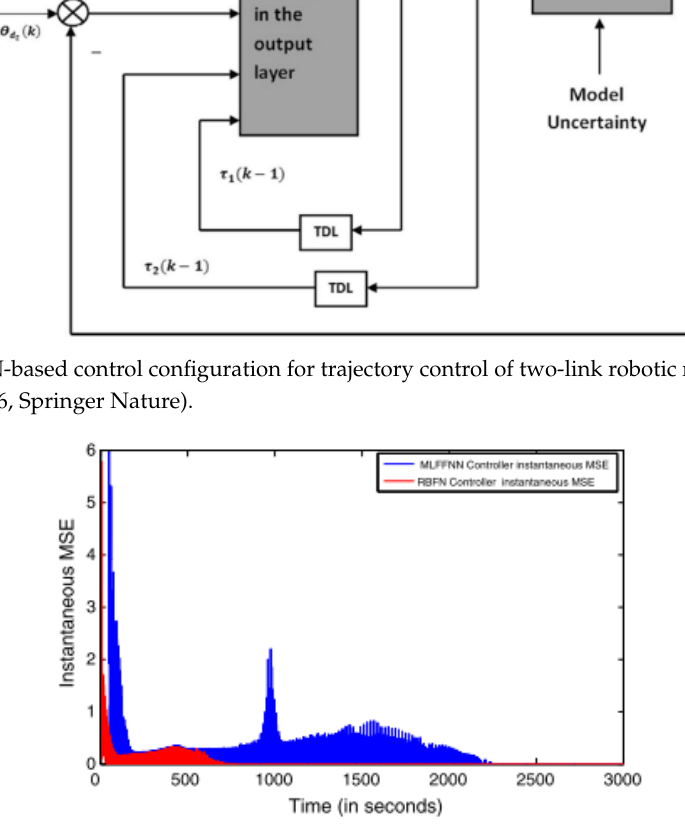
Figure 5. MSE under RBFN controller action [59] (Copyright 2016, Springer Nature).